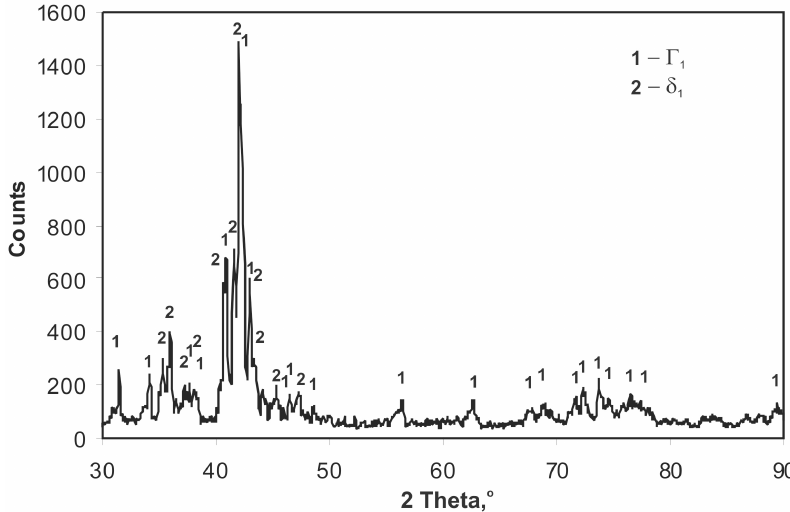
Figure 4. Diffractogram of the surface of skew-ground coating obtained on high-strength grade 10.9 bolts through thermal diffusion method with reactive atmosphere recirculation.